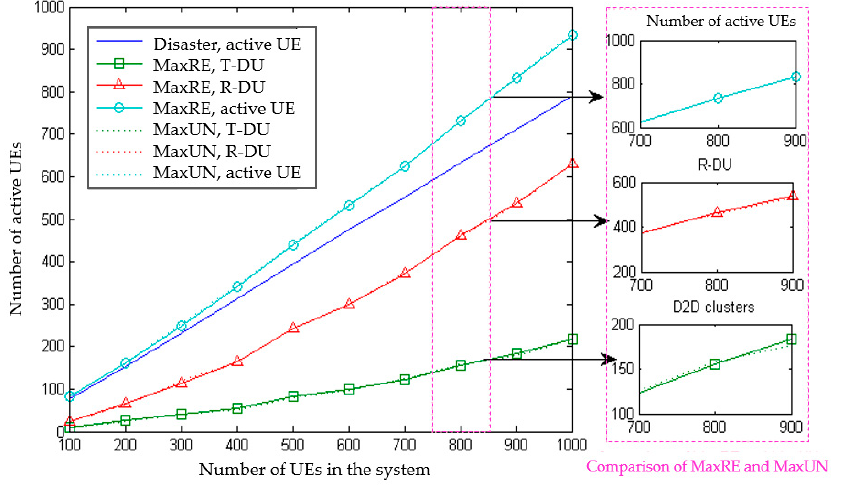
Figure 5. The comparison of UE states under different system user numbers.